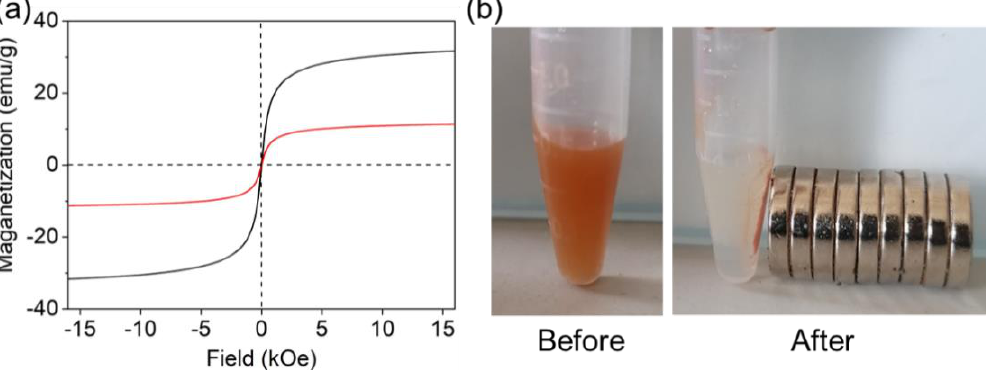
Figure 3. VSM curve of magnetic MIL-68(Ga) ( a ) and photographs of the magnetic MIL-68(Ga) solution before and after magnetic separation ( b ).